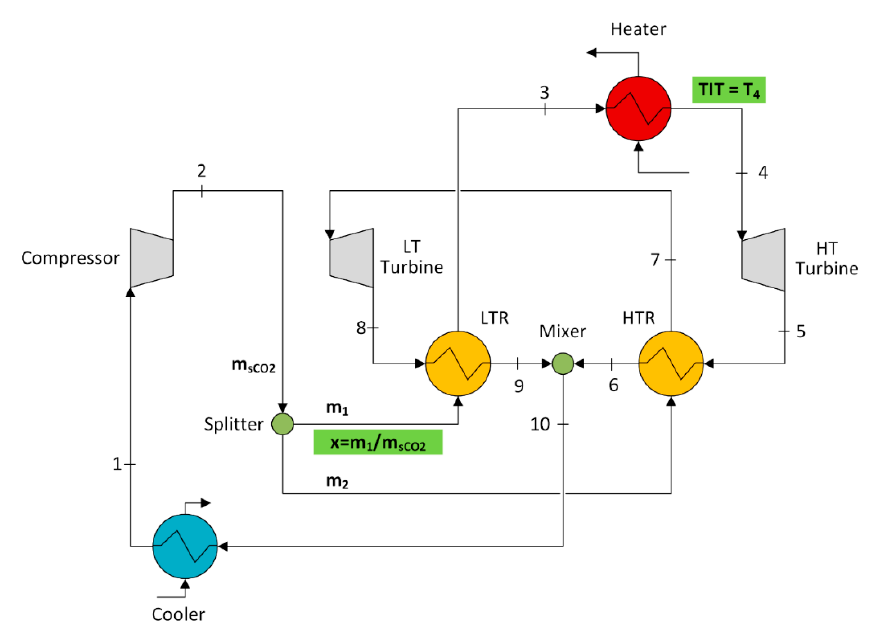
Figure 5. Dual recuperated s-CO 2 cycle.